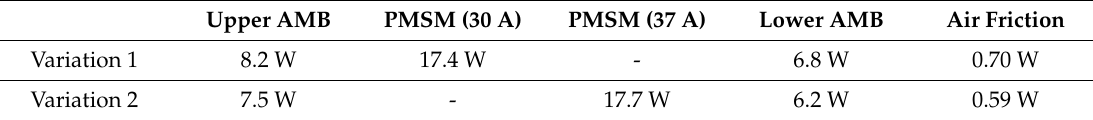
Figure 14. ( a ) Variations of increasing the cycle time to reduce the rotor temperature; ( b ) Steady state rotor temperature of both cycle variations with a reduced bias current of 4 A in both AMBs with a specimen. Table 4. Mean rotor losses during cycling variation 1 and 2 with a reduced bias current of 4